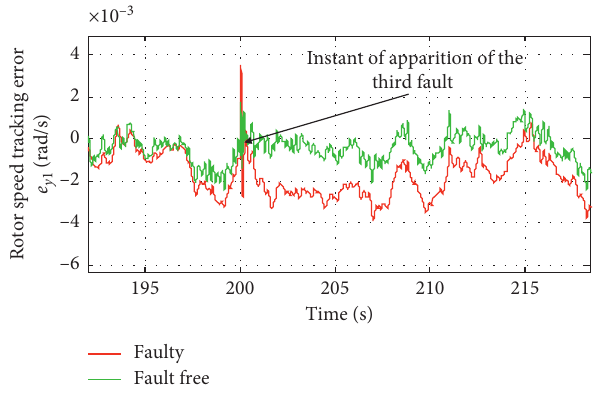
Figure 7: The rotor speed tracking error. Figure 8: The estimated blade 1 deflection velocity tracking